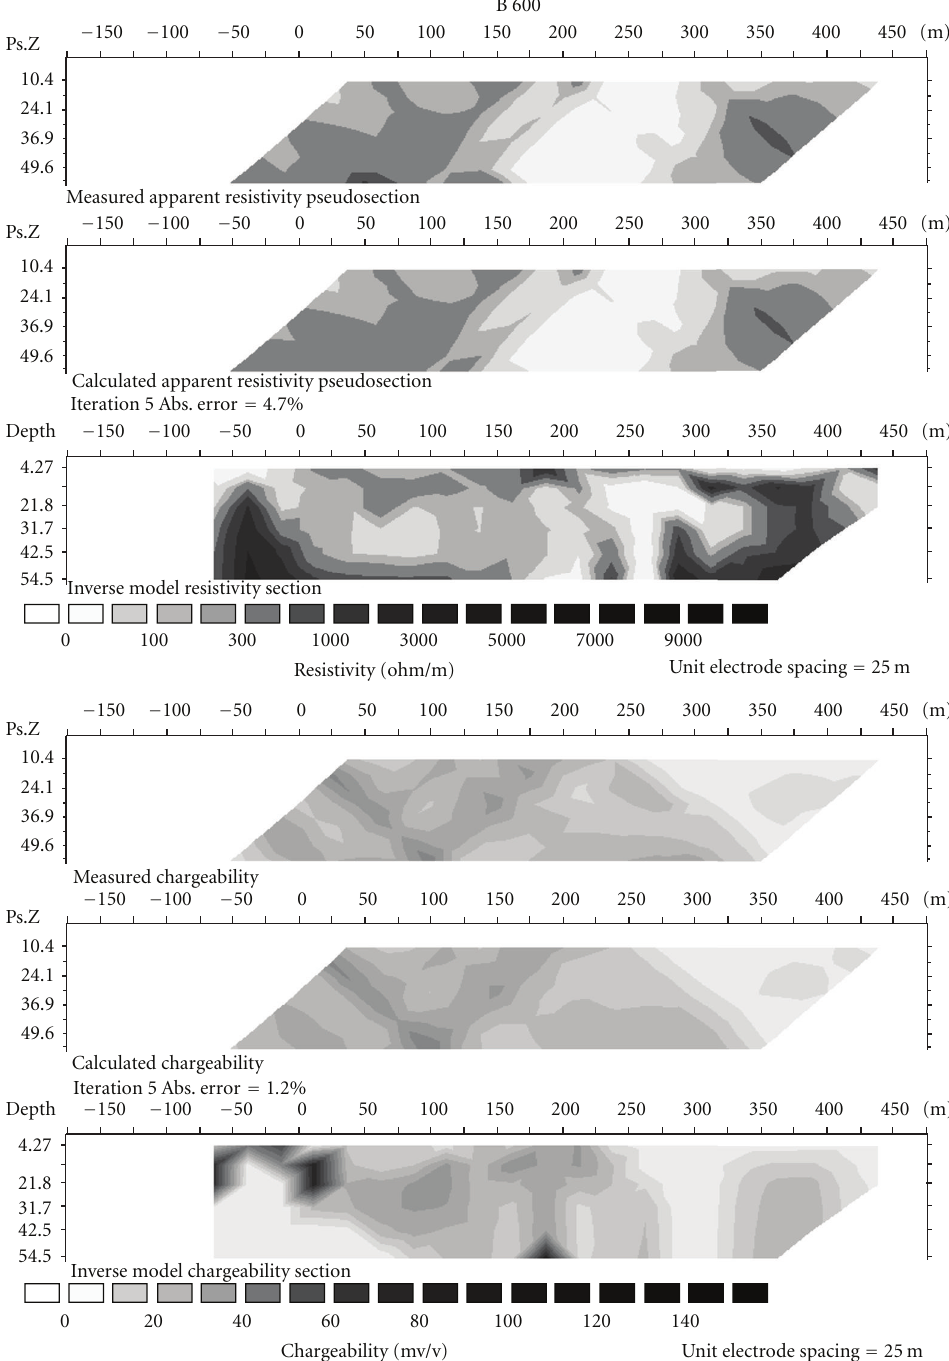
Figure 4: Measured and calculated apparent pseudosections and inverse models sections of resistivity and chargeability for no. 600 Brech´on